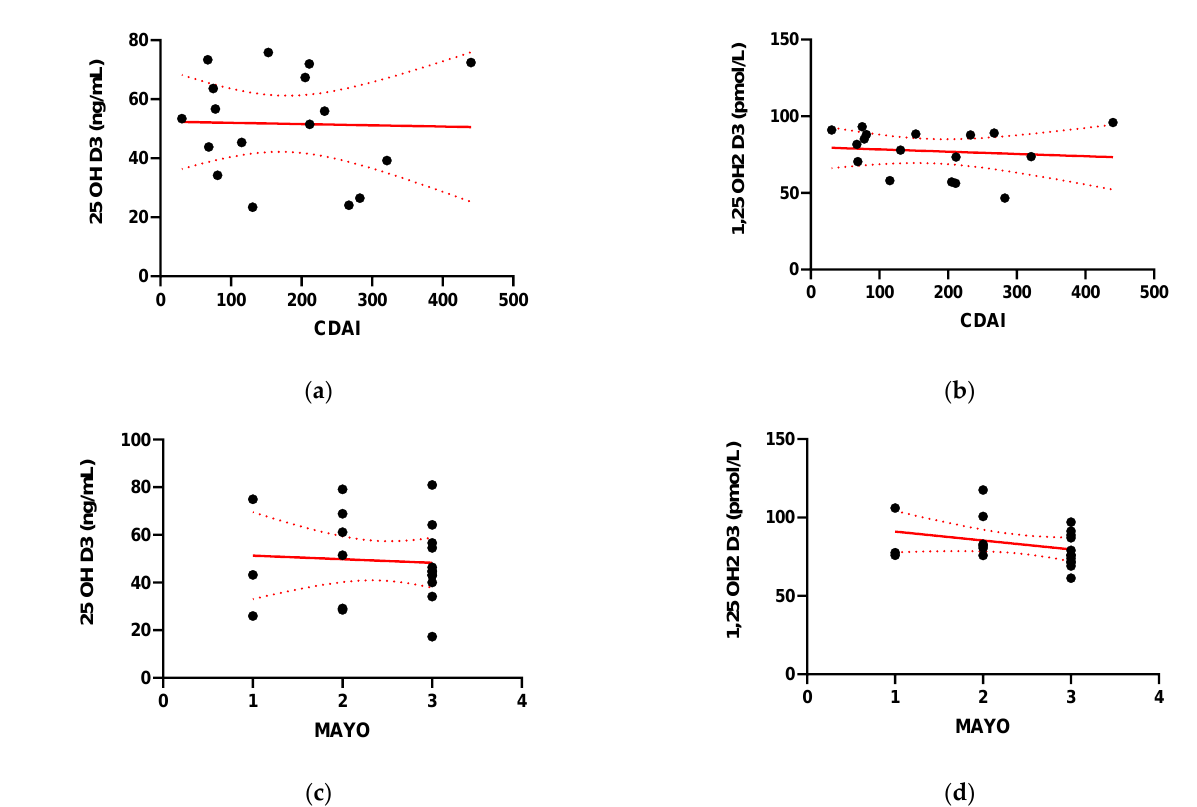
Figure 3. Correlation between serum concentration of 25-hydroxy Vitamin D (25(OH) Vitamin D) ( a ) and 1,25-hydroxy Vitamin D (1,25(OH)2 Vitamin D) ( b ) and the value of the Crohn's Disease Activity Index for Crohn's disease (CD) patients ( c ); and the value of Mayo score (c and d respectively) for ulcerative colitis (UC) patients ( d ).